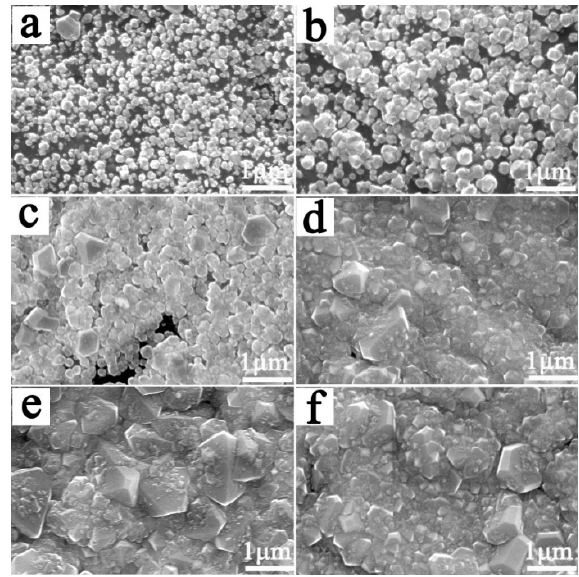
Figure 1. Morphology of Boron doped diamond (BDD) coatings deposited for 2 h at different CH 4 flow rates:( a ) 4 sccm; ( b ) 6 sccm; ( c ) 7 sccm; ( d ) 8 sccm; ( e ) 10 sccm; ( f ) 14 sccm.